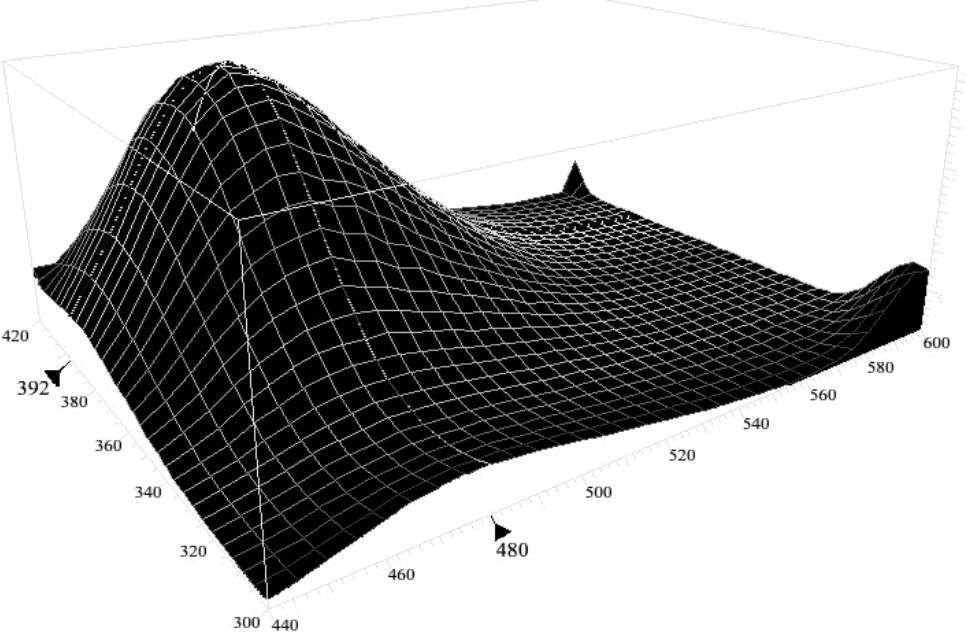
Figure 1. Luminance 3D graph of the GSH-MBB adduct obtained by means of an HPLC 1100 device equipped with a fluorimetric detector and ChemStation software version A.06.03 Agilent Technologies LC/MSD Cernusco sul Naviglio